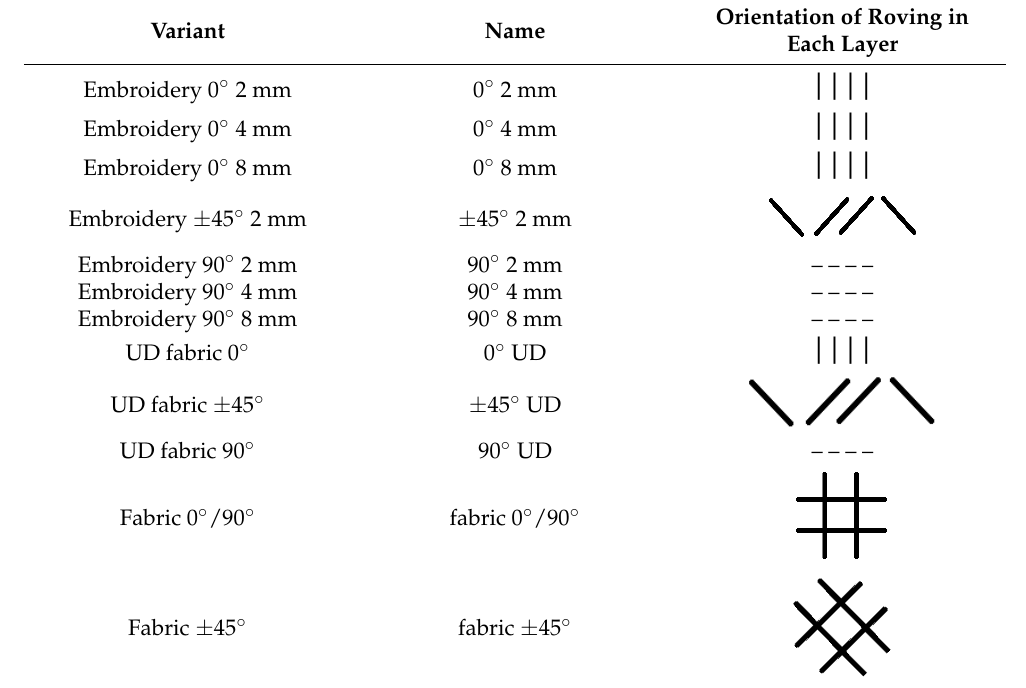
Table 1. Types of produced reinforcements.